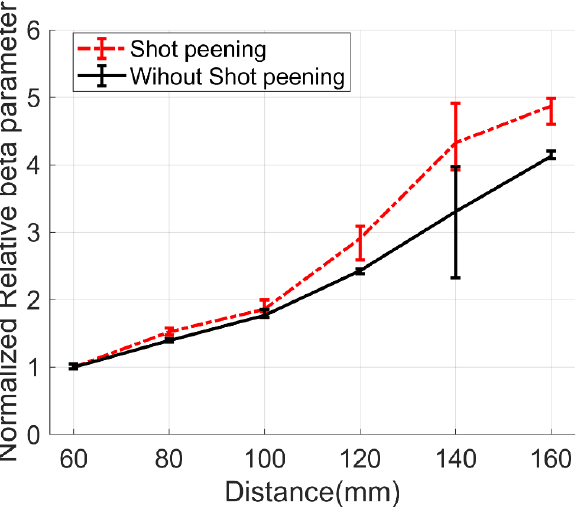
Figure 9. Nonlinearity with shot peening and without shot peening.